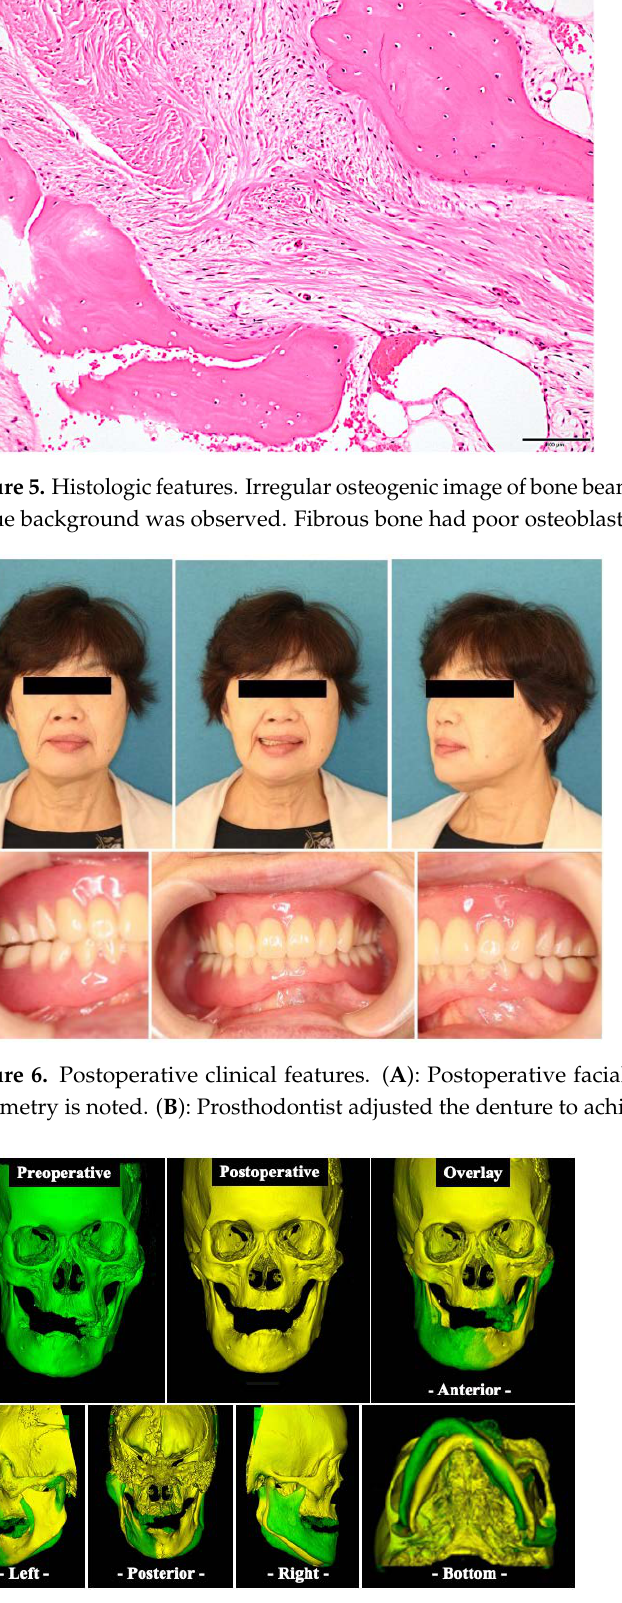
Figure 7. Three-dimensional (3D) based evaluation of craniomaxillofacial bone models. Preoperative (green) and postoperative (yellow) 3D scan of the craniomaxillofacial bone model and overlay (green and yellow) of both scans.